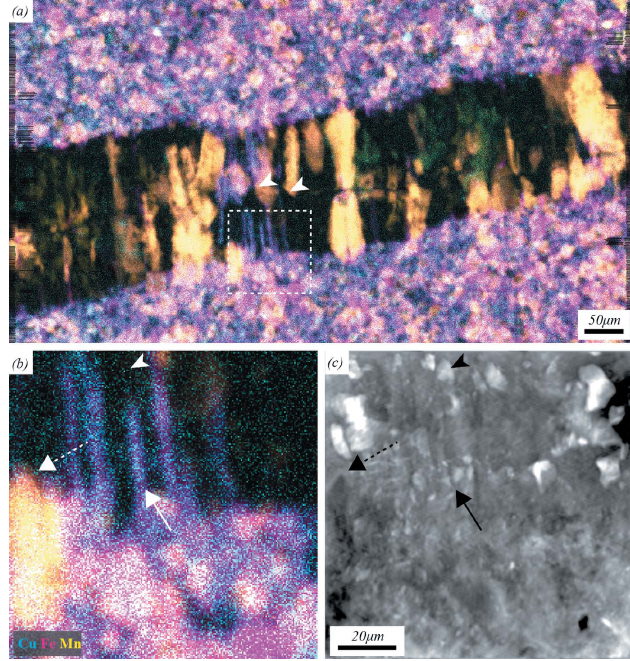
Figure 6 A large-area correlated SXDM-XFM image of a small vein in a freestanding thin section of shale. ( a ) An XFM image of the entire 800 m m (cid:3) 440 m m scan area is shown in cyan, magenta and yellow for Cu, Fe and Mn, respectively. ( b ) An enlargement of the region of interest (ROI) of the 100 m m (cid:3) 100 m m area indicated by the dashed square in panel ( a ). ( c ) An SXDM phase-contrast reconstruction in the same ROI, revealing high-resolution high-contrast structural information. For explanation, see main text.